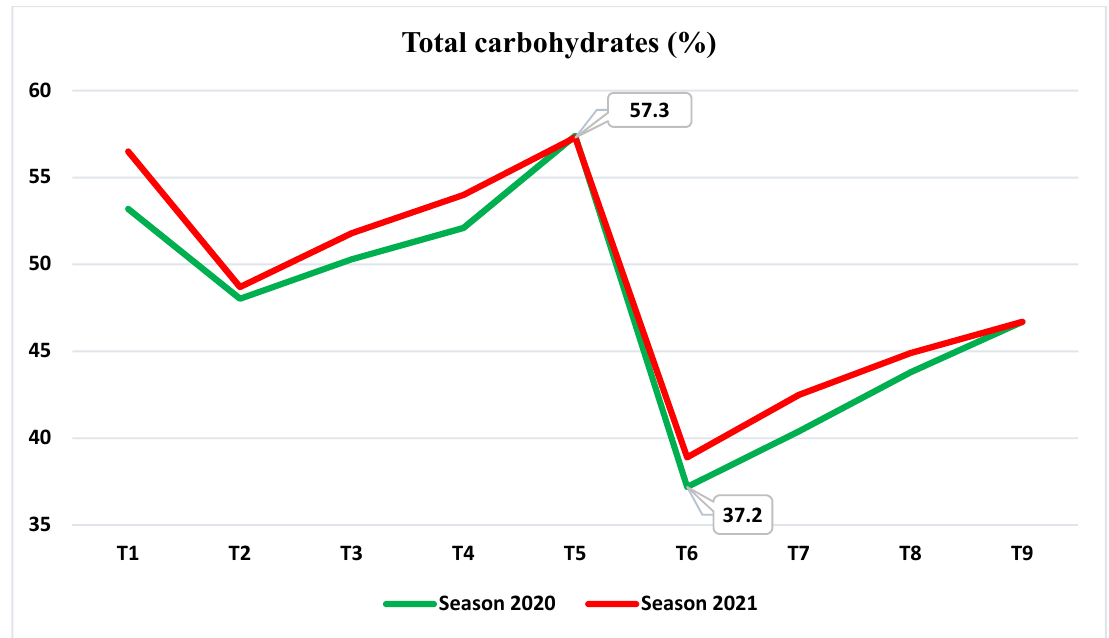
Figure 5. Effect of mineral fertilizer alone or combined with SAPs on shoot total carbohydrate content (%) of Autumn Royal grapevines in 2020 and 2021 seasons.